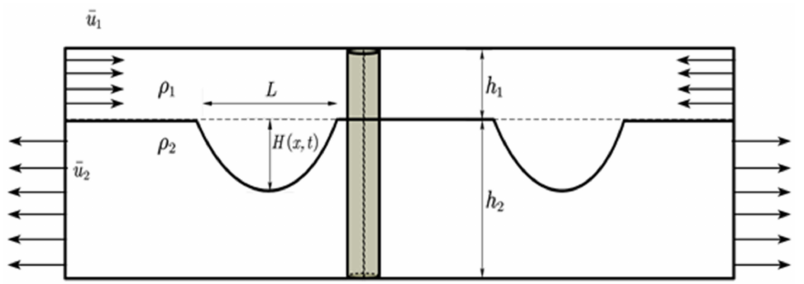
Figure 1. Schematic diagram of numerical water